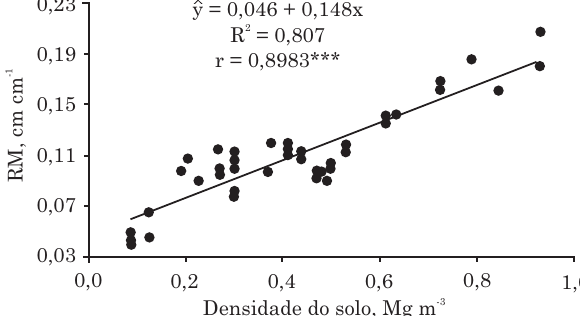
Figura 3. Correlação entre a densidade do solo (Ds) e o resíduo mínimo